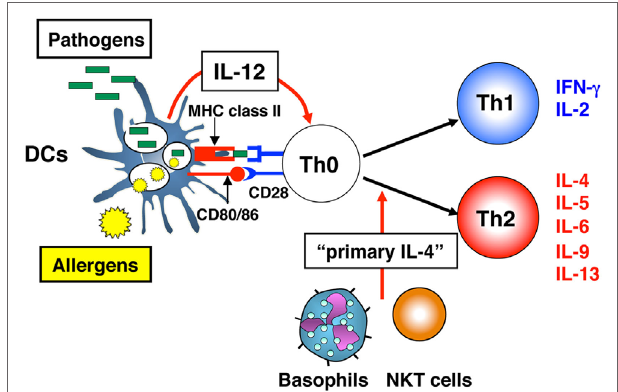
FigURe 1 | Differentiation of naïve CD4 + T cells into T helper (Th)1 or Th2 cells. Differentiation of naïve CD4 + T cells into Th1 or Th2 cells requires three signals: (1) T cell receptor (TCR) triggering through peptide-antigen recognition in the context of MHC class II molecules; (2) augmentation of TCR signaling via CD80 and/or CD86 and CD28 co-stimulatory molecules; and (3) an appropriate cytokine, interleukin (IL)-12 for Th1 cell differentiation and IL-4 for Th2 cell differentiation. For Th1 cell differentiation, which develops in response to viral and bacterial pathogens, dendritic cells (DCs) function as antigen-presenting cells and provide all three signals. For Th2 cell differentiation, which develops in response to an allergen, DCs cannot provide all three required signals, because of the lack of “primary IL-4,” the cytokine essential for Th2 cell differentiation. Cells, such as natural killer T (NKT) cells or basophils are candidate “primary IL-4”-producing